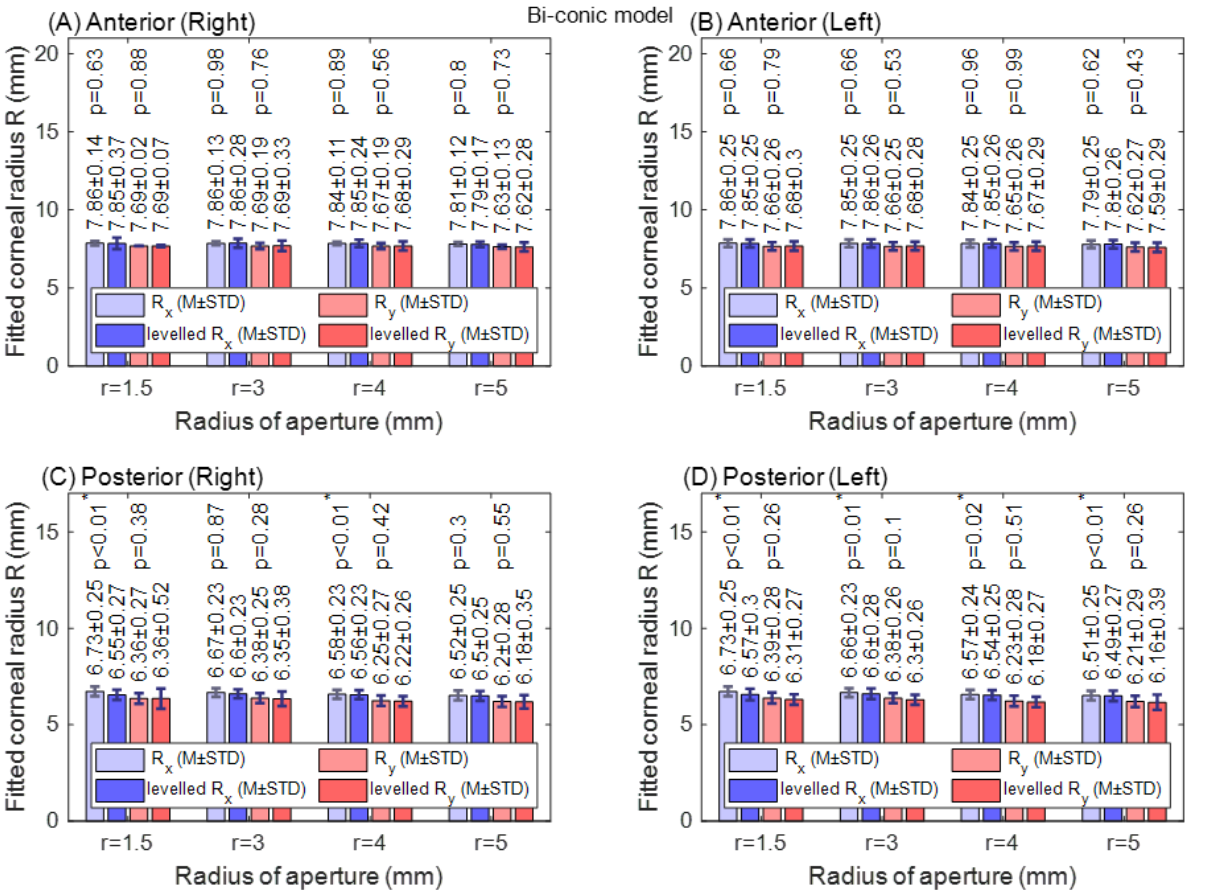
Figure 7. Corneal apical radius (R) fitted to biconic model with different radii of aperture (r). R x : nasal–temporal. R y : superior–inferior. The asterisk (*) indicates the statical significance. ( A )Anterior right corneal fitted radii; ( B ) Anterior left corneal fitted radii; ( C ) Posterior right corneal fitted radii; ( D ) Posterior left corneal fitted radii.